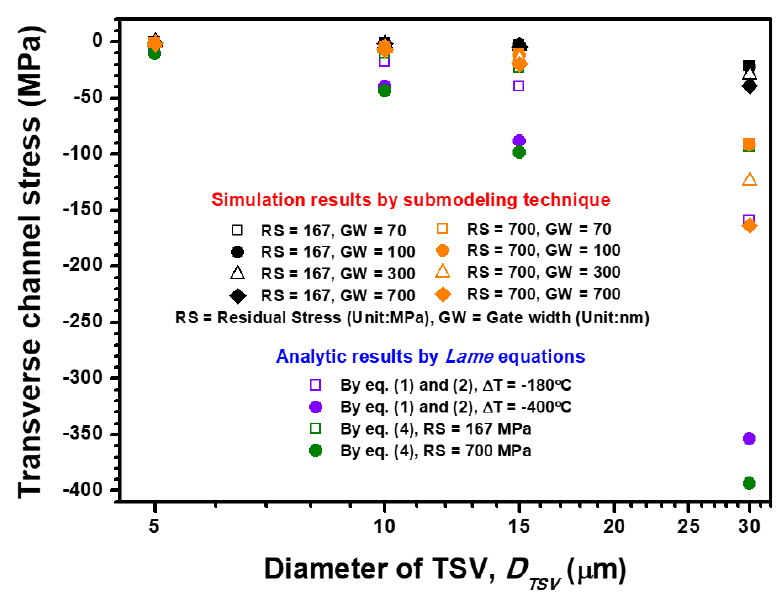
Figure 7. TSV-diameter, TSV-residual stress magnitude and channel gate width dependence trans- verse channel stress (stress along the channel width direction) estimated by the analytical formula, semi-empirical formula and FEA submodeling simulation.